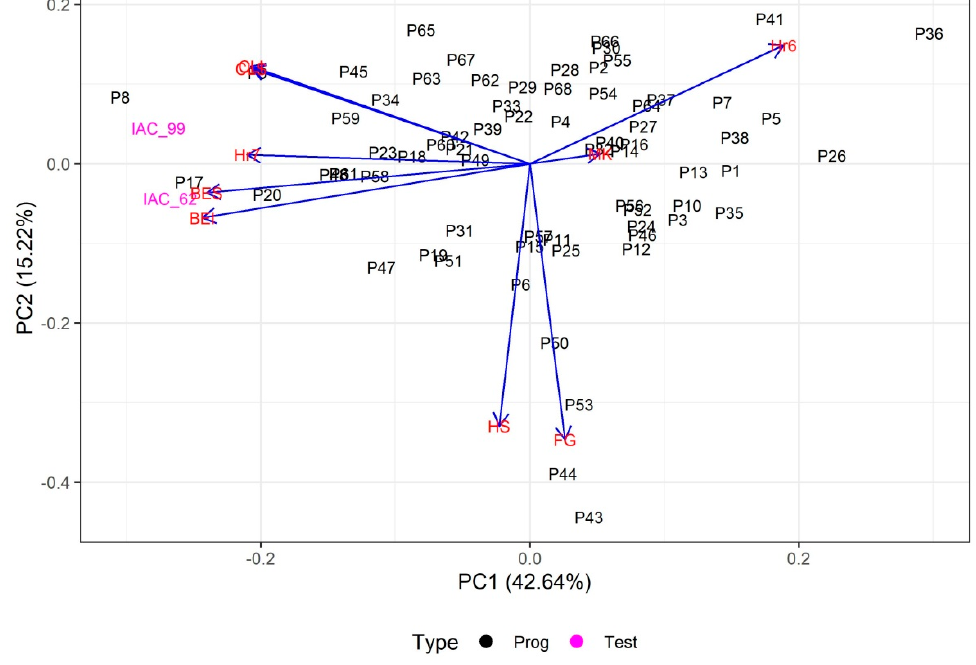
Figure 3. Dispersion of the progeny means as a function of the coordinates for the first and second canonical dimensions obtained from nine traits: CLI, CLS, BEI, BES, MK, HS, FG, Hr7, and Hr6.